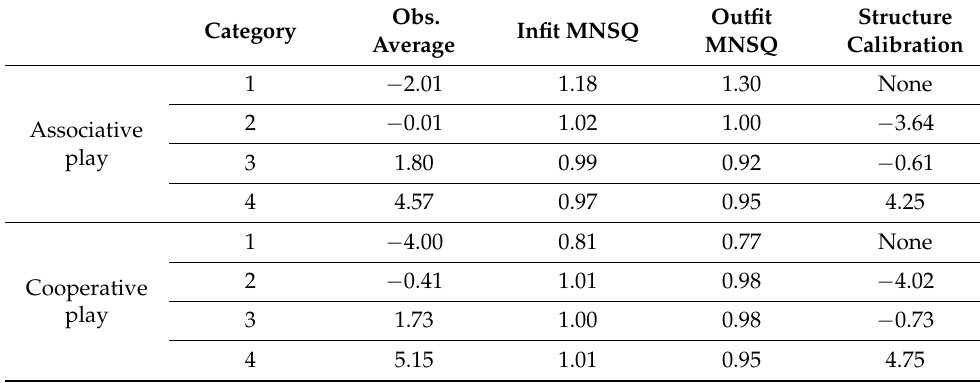
Table 2. Results of rating scale category statistics for the Associative play and Cooperative play. Obs. Outfit Category Infit MNSQ Average MNSQ